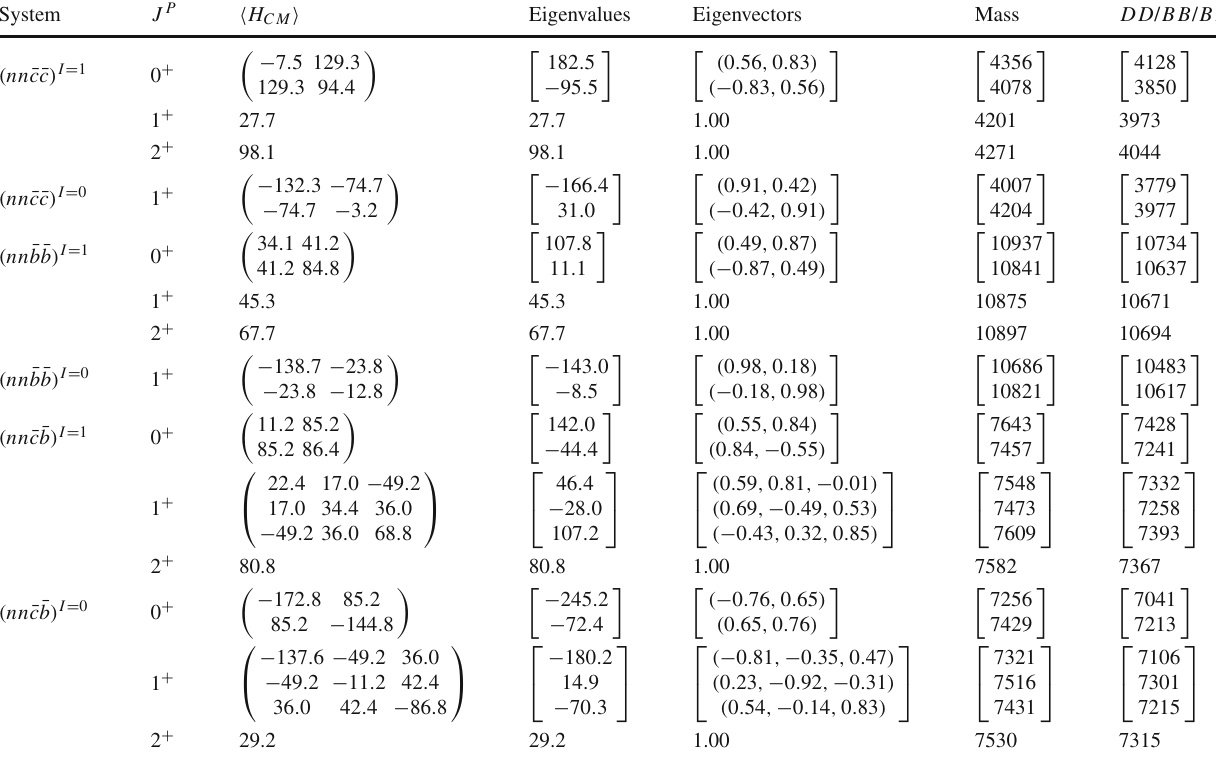
Table 6 Numerical results for the nn ¯ c ¯ c , nn ¯ b ¯ b , and nn ¯ c ¯ b systems in units of MeV, where n = u or d . The masses in the sixth column are estimated with the masses of effective quarks and those in the last column with the thresholds of DD / BB / BD